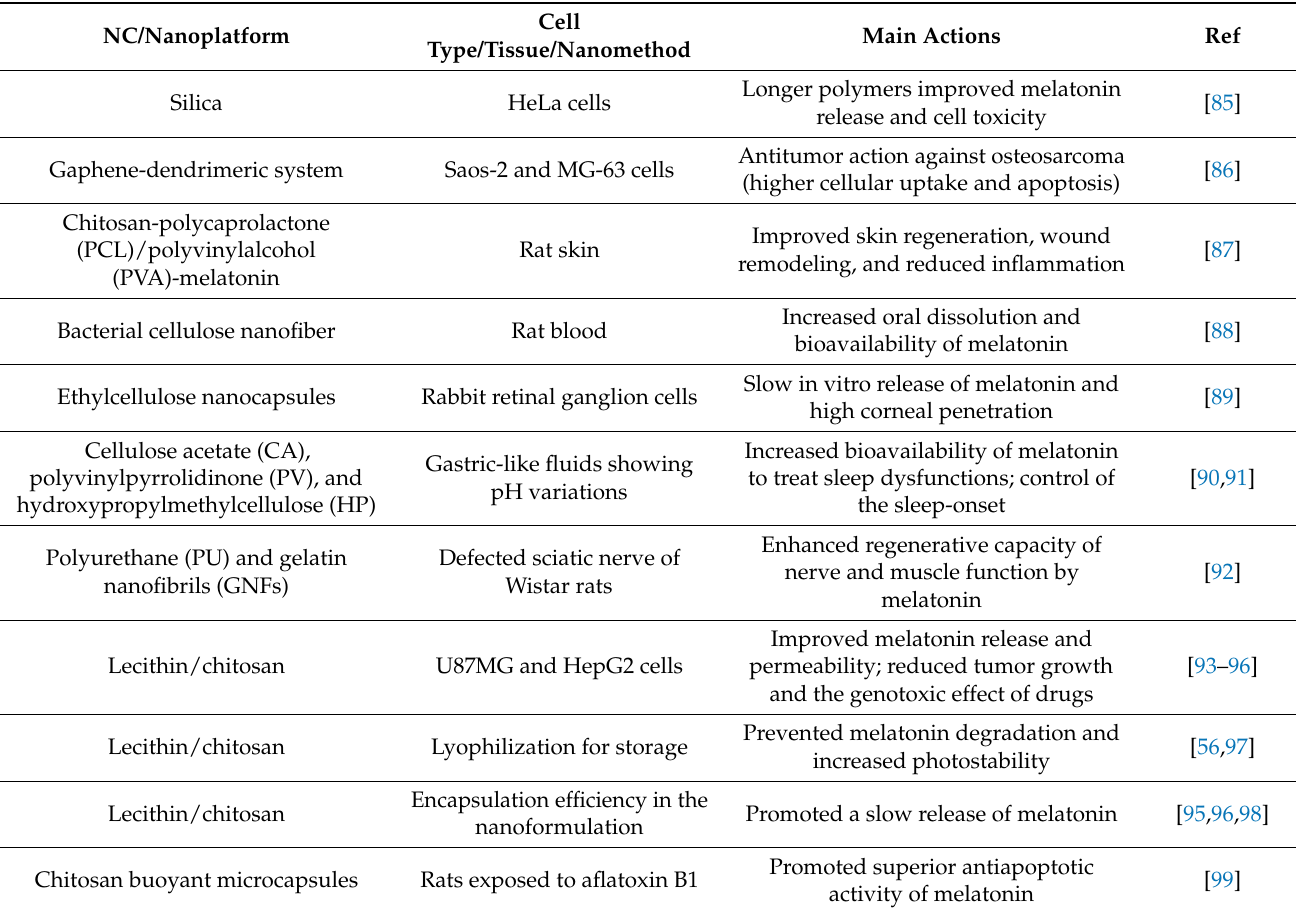
Table 1. Melatonin’s effects on different cell types and animal models after its incorporation into diverse NCs/nanoplatforms.